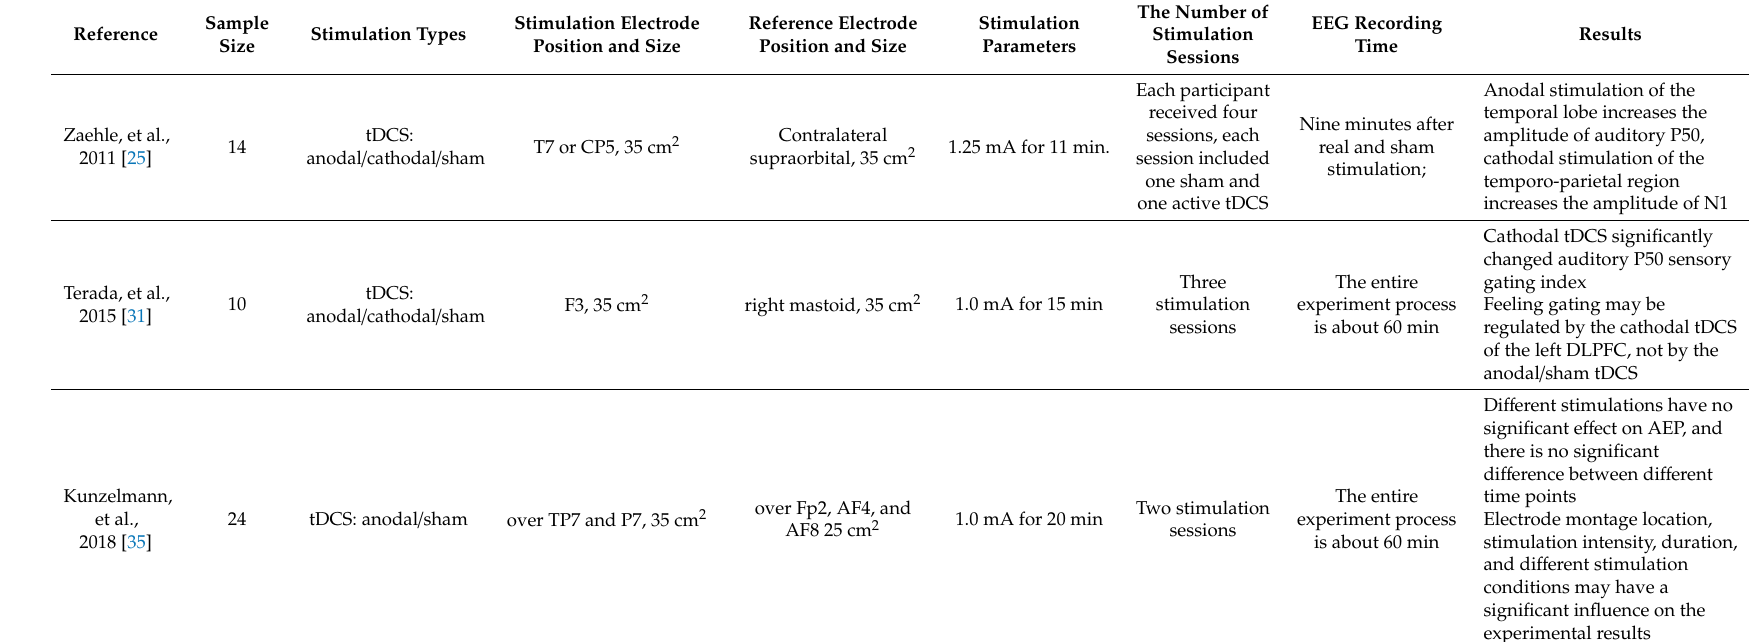
Table 1. Partial parameters and results of electrophysiological